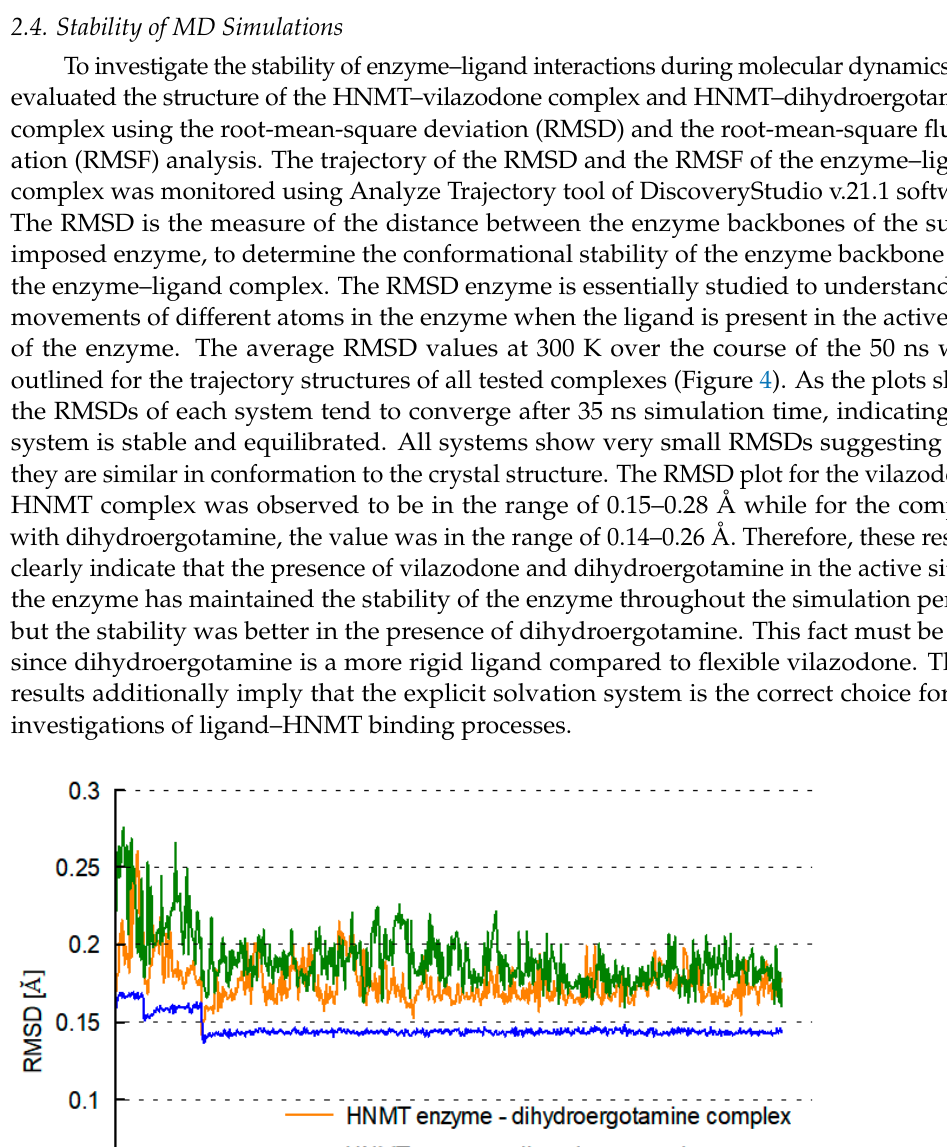
Figure 3. Interactions of the selected compounds with HNMT were obtained by 50 ns of MD simu- lations. Vilazodone–HNMT complex; binding mode ( A ) and non-bonding interactions ( B ). Dihy- droergotamine–HNMT complex; binding mode ( C ) and non-bonding interactions ( D ).